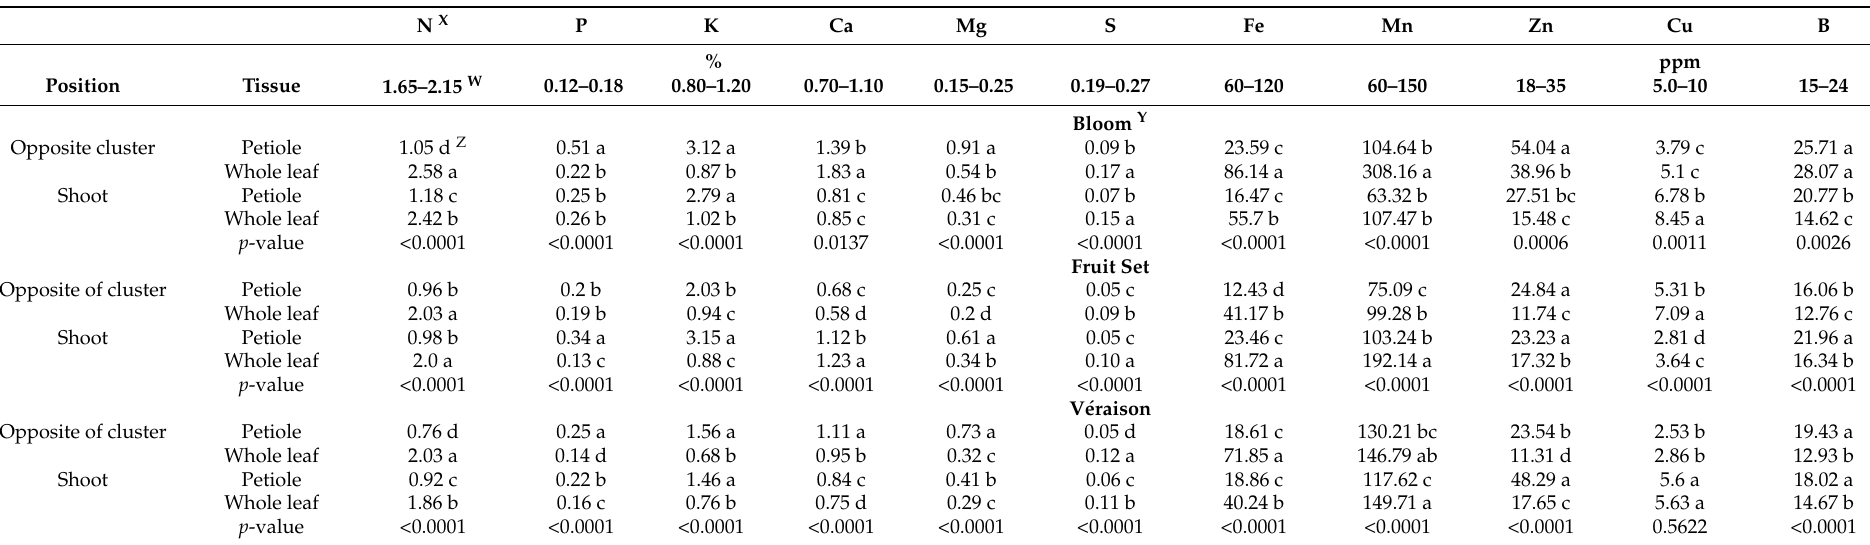
Table 2. Nutrient concentrations of petiole and full-leaf from two sampling positions in mature muscadine ‘Carlos’ in 2019 ( n =